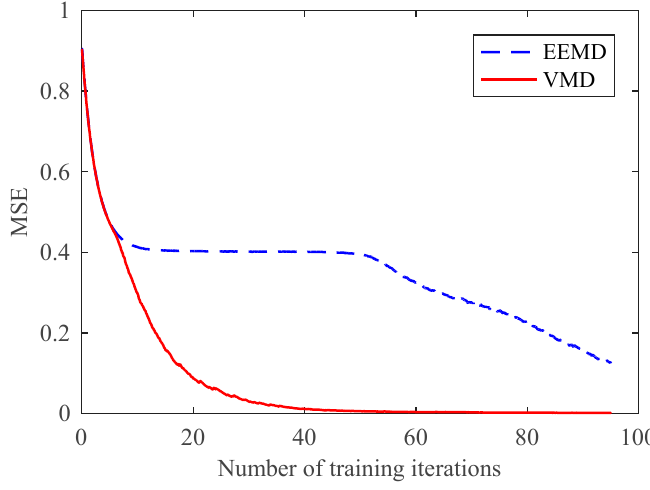
Figure 11. Mean square error (MSE) curves of CNN.